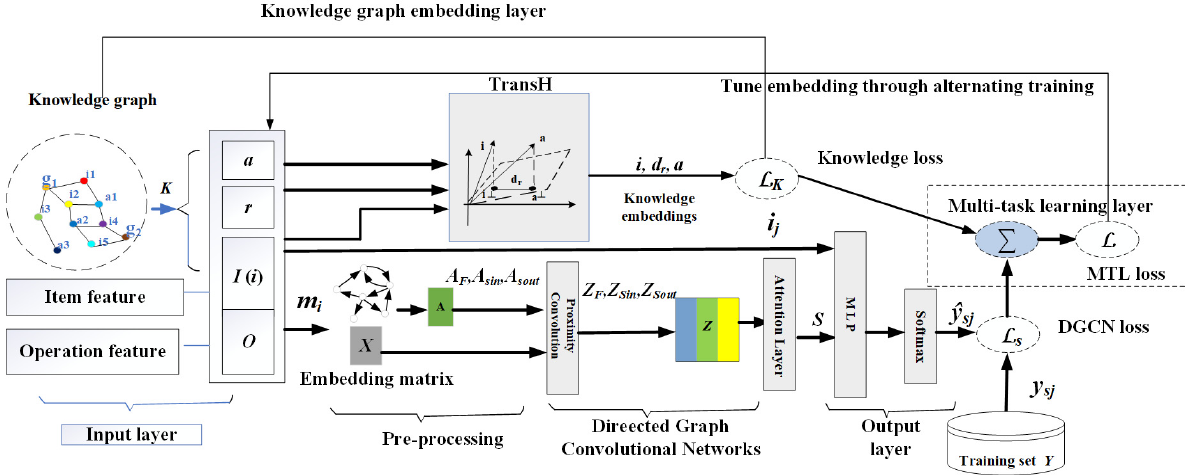
Figure 1. Overall architecture of the MTL-DGCNR model.